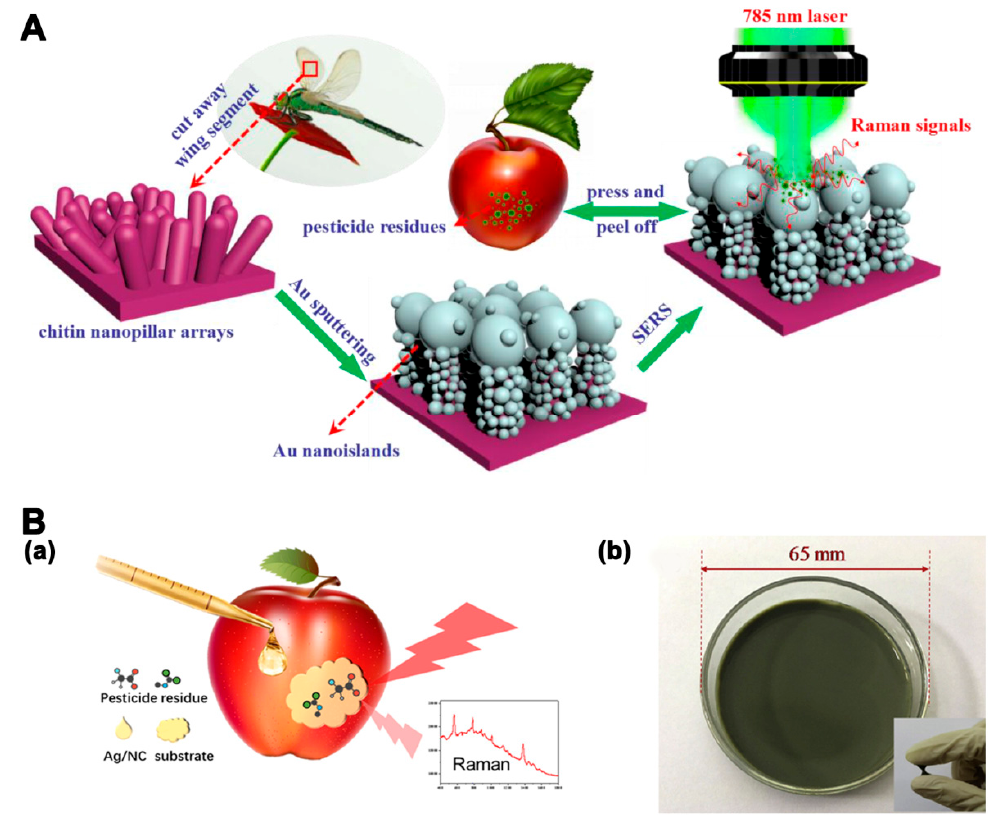
Figure 6. ( A ) Illustration of an au-decorated dragonfly wing bioscaffold array as a surface-enhanced Raman scattering (SERS) substrate by the Raman system [115]. ( B ) a. Illustration of the SERS measurement of apples. b. Photograph of the Ag/NC substrate [117]. Reproduced with permission from [115]. Copyright MDPI, 2018. Reproduced with permission from [117]. Copyright Elsevier, 2019.